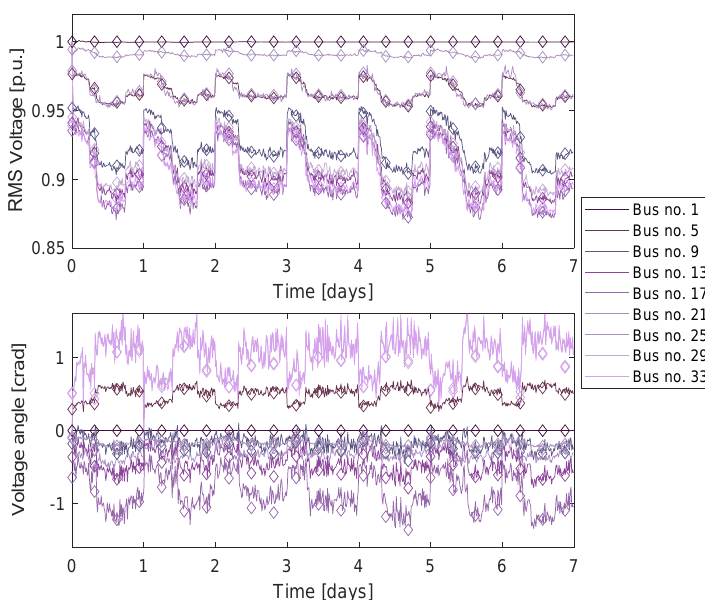
Figure 4. RMS voltage ( top picture ) and angles ( bottom picture ) state estimates at different buses obtained with the proposed enhanced EKF algorithm during the first week of January. In this example, load variability is set to ± 60% of the nominal values and no smart meter (SM) or Phasor Measurement Unit (PMU) data are used. The diamond markers represent the true values of the corresponding state variables and are shown for